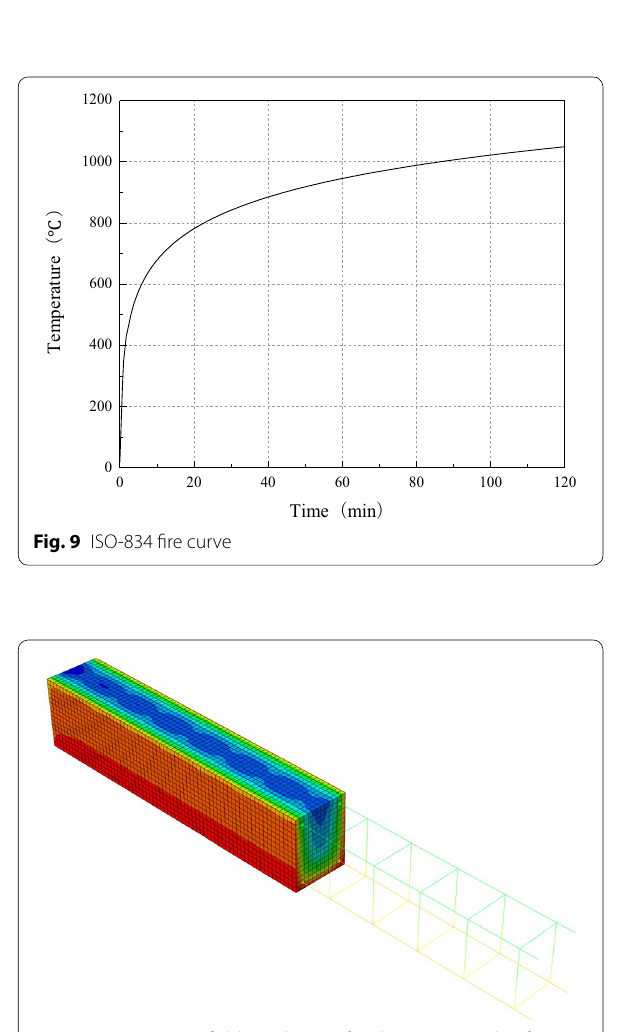
Fig. 10 Temperature field simulation of RC beam exposed to fire